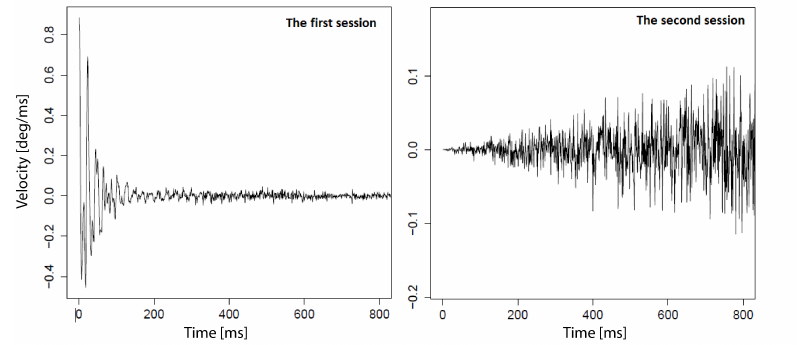
Figure 3. Examples of two time series registered for the same stimulus position and for one participant, yet during different sessions. The first session with the correct signal is shown on the left, while the signal registered during the second session with abnormal features is visible on the